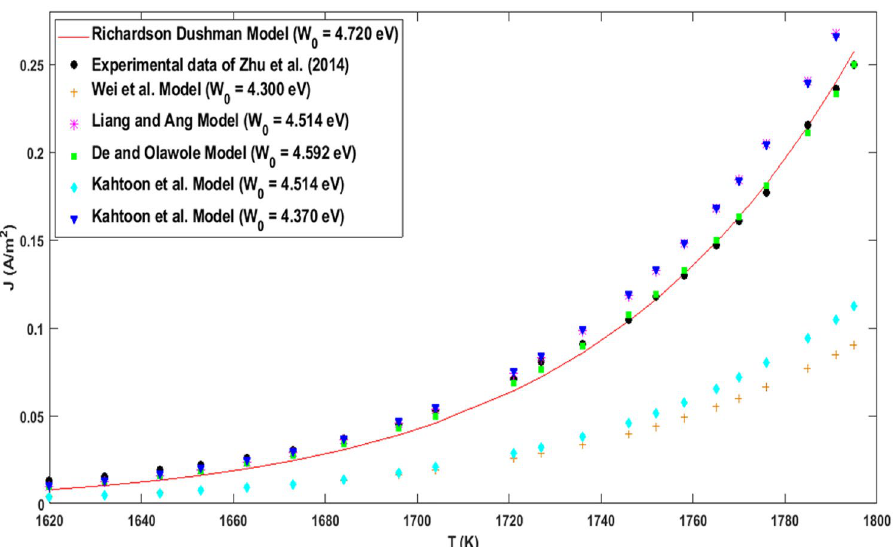
Figure 3. Best fitting of the theoretical thermionic emission current density of graphene with experimental data (black dotted points) for different models of graphene. The solid red line for Eq. (6) (RD model), yellow cross for Eq. (7) (Wei et al., model), magneta solid for Eq. (8) (Liang and Ang model), cyan diamond and blue triangular for Eq. (10) (Khatoon et al., model), and green square for Eq. (11) (De and Olawole